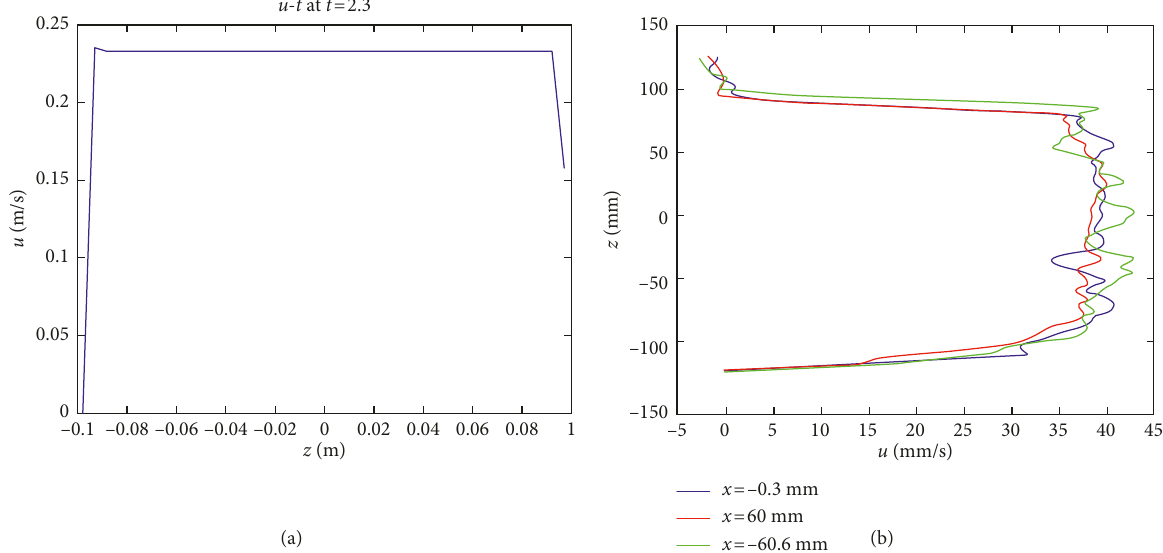
Figure 4: Comparison of the velocity profile for oscillatory flow. (a) Velocity profile for oscillatory Poiseuille flow at t A 0.1m. (b) PIV (cid:31)